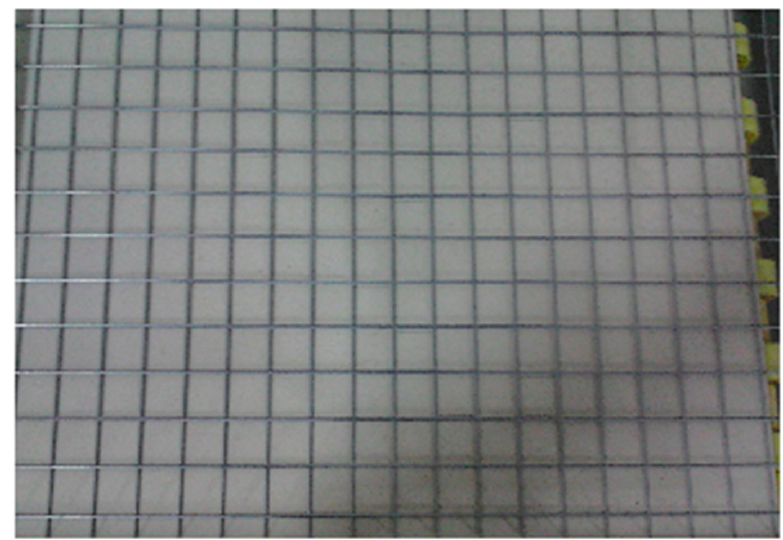
Figure 8. Experimental setup used to measure gloss data, using a wired grid with cells of 30 × 30 mm 2 , where each gloss measurement takes place.